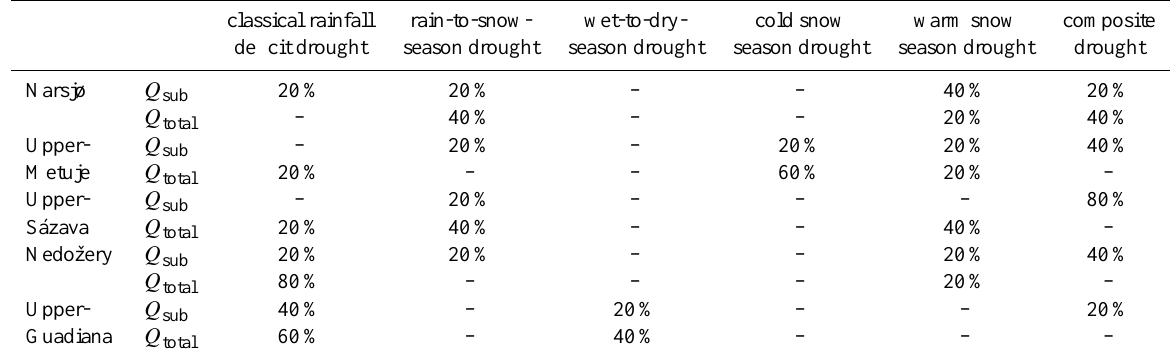
Table 6. Hydrological drought types of the five most severe hydrological drought events per catchment (subsurface runoff and total runoff), selection based on deficit